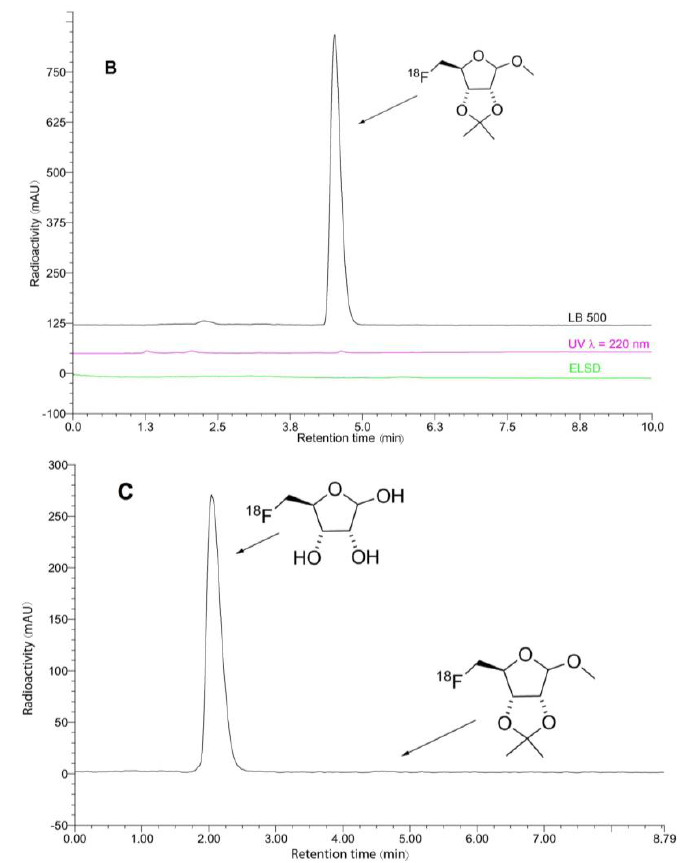
Figure 5. HPLC chromatograms of the crude and purified [ 18 F] 6 (( A , B ), respectively), and 5-[ 18 F]FDR ([ 18 F] 7 , ( C )). Conditions: column: Phenomenex Luna C18(2), 250 × 4.6 mm, 5 µm; eluent: 0–5.5 min 55 → 95% MeCN; 5.5–8.0 min 95% MeCN; flow rate: 1.3 mL/min; t R = 4.5 min ([ 18 F] 6 ), t R = 2.0 min (5-[ 18 F]FDR). Radioactivity, UV- (λ = 210 nm), and ELSD-traces are shown in black, violet, and green, respectively.